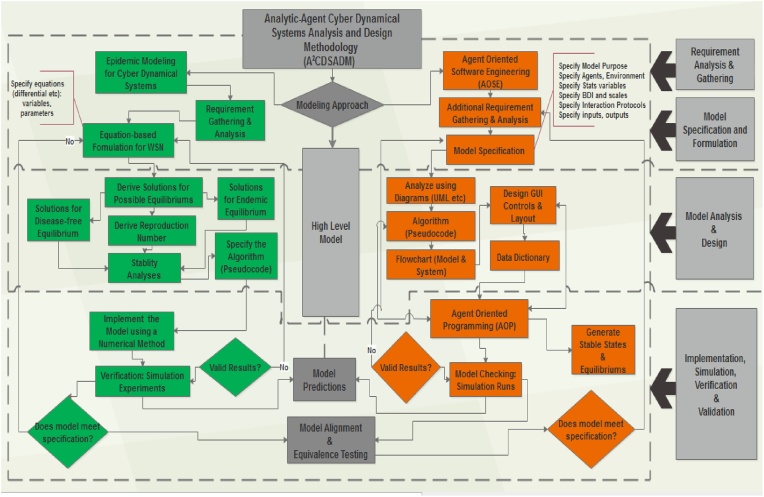
Diagrammatic representation of the A2CDSADM.